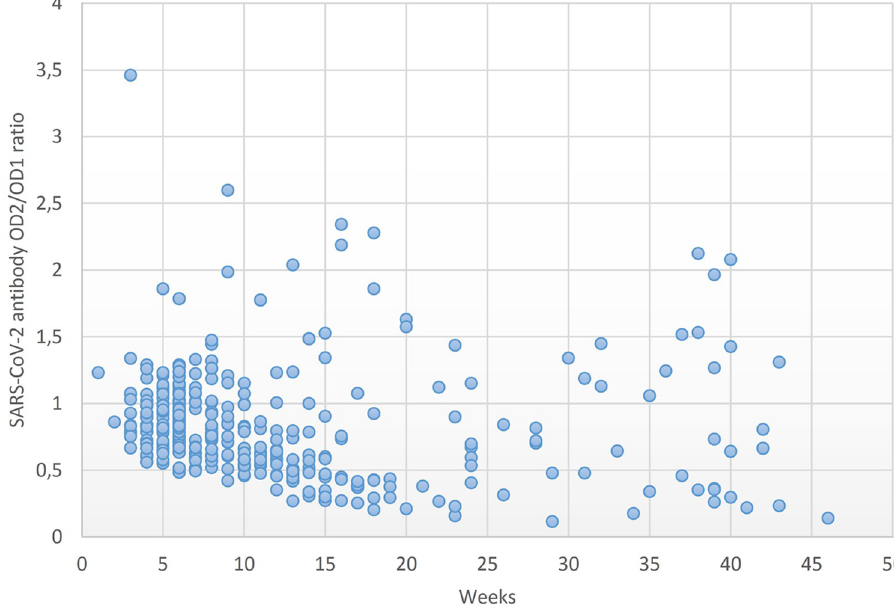
Fig 1. OD ratios along time. OD ratios from total immunoglobulins recognizing SARS-CoV-2 N protein of second over first donation are represented vs time lapse between them (weeks). OD: Optical density.